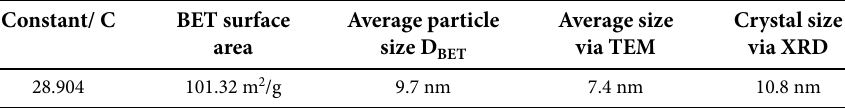
Table 2. BET results of synthesized ZnO NPs in comparison with other analytical techniques. Constant/ C BET surface